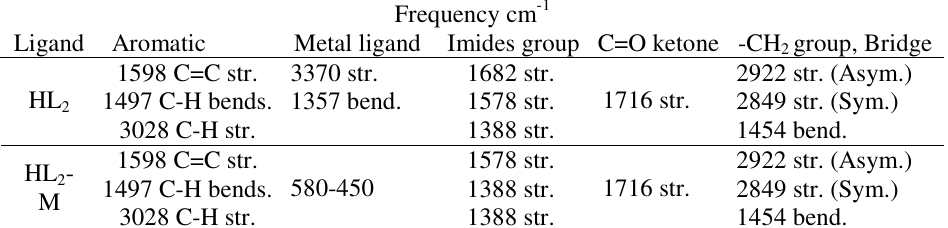
and their metal complexes. 2